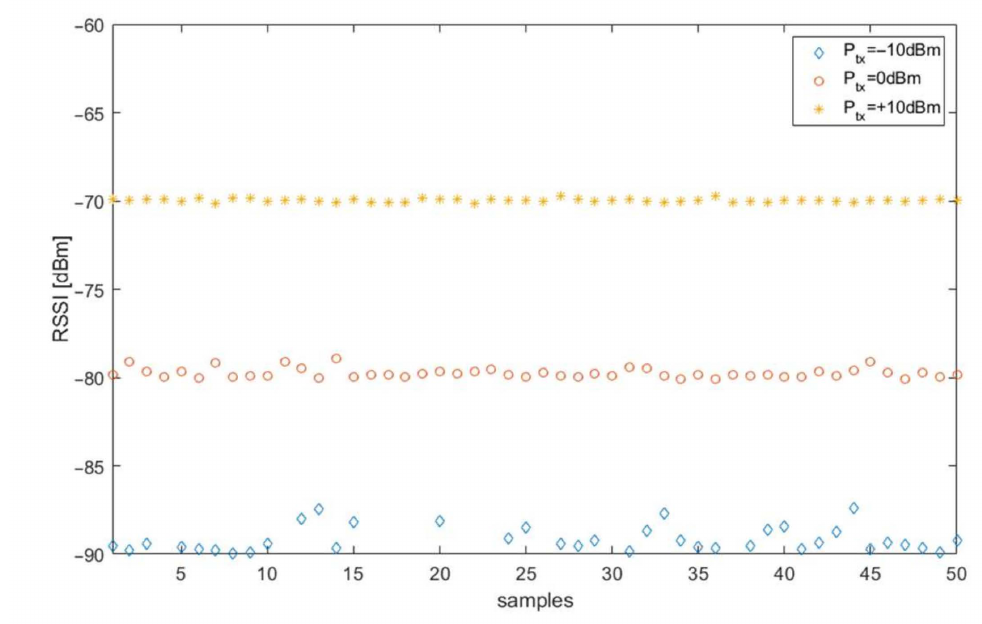
Figure 4. Simulation of the received RSSI values for different transmitter power values when operating on a radio